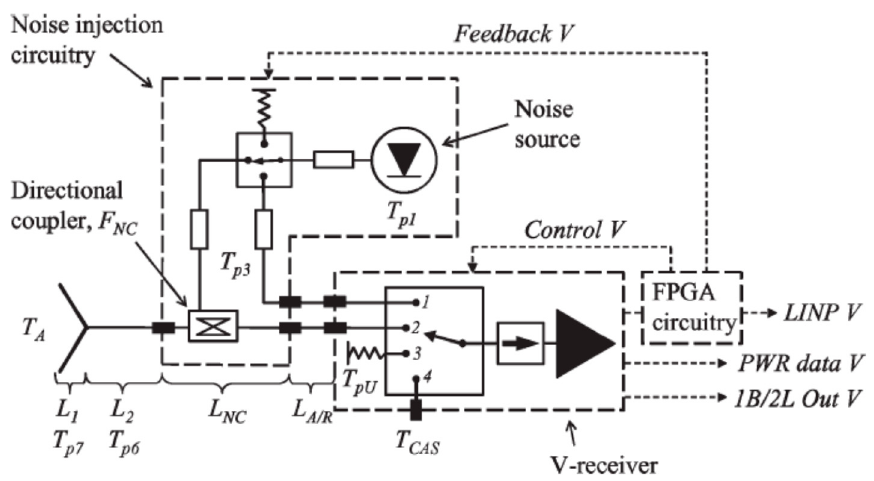
Figure 3. Schematic diagram of the structure of the V-channel of the NIR. L stands for loss, Tp for physical temperature, TA for antenna temperature and Tcas for the Calibration Subsystem (CAS) noise temperature [6].